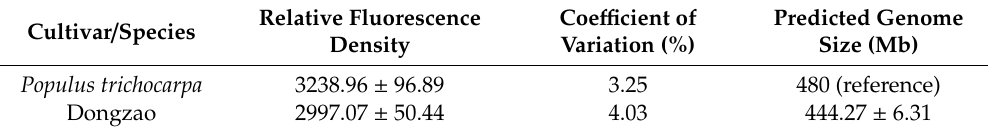
Table 1. Genome sizes of Z. jujuba “Dongzao” and P. trichocarpa.